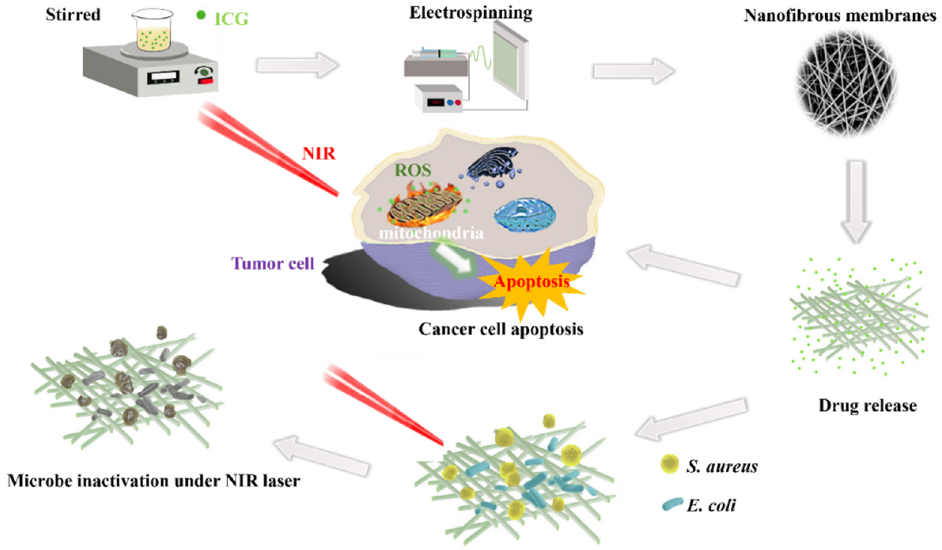
Scheme 1. Schematic illustration of the preparation and SF/PLGA/20ICG for microbe inactivation and cancer treatment.